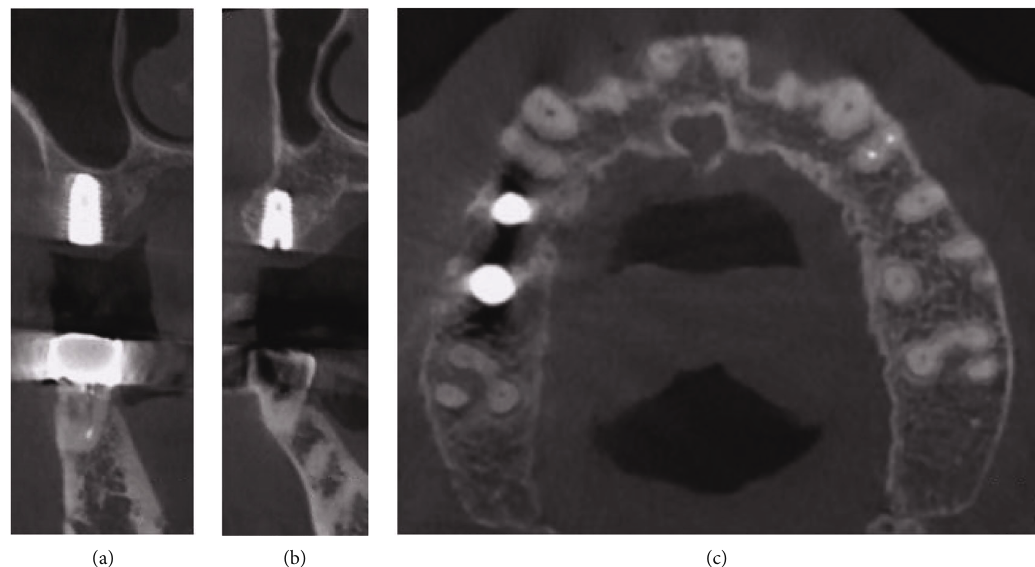
Figure 4: (a – c) Post-implantation radiograph views (Case 1). The width of the alveolar bone was well-maintained, and the implants were placed.